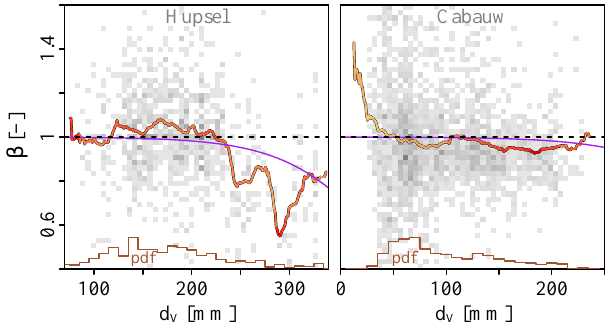
Figure 6. Determining the evapotranspiration reduction function. Fig. 6. Determining the evapotranspiration reduction function. Soil Soil moisture data are from the meteorological station in the Hupsel moisture data are from the meteorological station in the Hupsel Brook catchment and the mean of four sites in the Cabauw polder. Brook catchment and the mean of 4 sites in the Cabauw polder. The orange-red lines connect the bin means, with the colour rang- The orange-red lines connect the bin means, with the colour rang- ing from low (orange) to high (red) inverse variance. The purple ing from low (orange) to high (red) inverse variance. The purple lines, with coefficients ζ 1 = 0 . 02 and ζ 2 = 400, are implemented lines, with coefficients ζ 1 = 0 . 02 and ζ 2 = 400 , are implemented as default in WALRUS. The brown histograms are the probability as default in WALRUS. The brown histograms are the probability density functions of storage deficit. density functions of storage deficit.